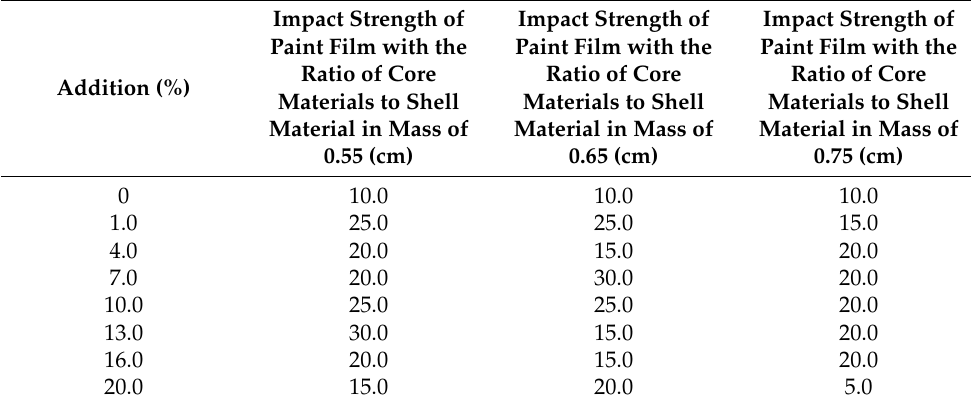
Table 2. Effect of microcapsule content on impact resistance of paint film.